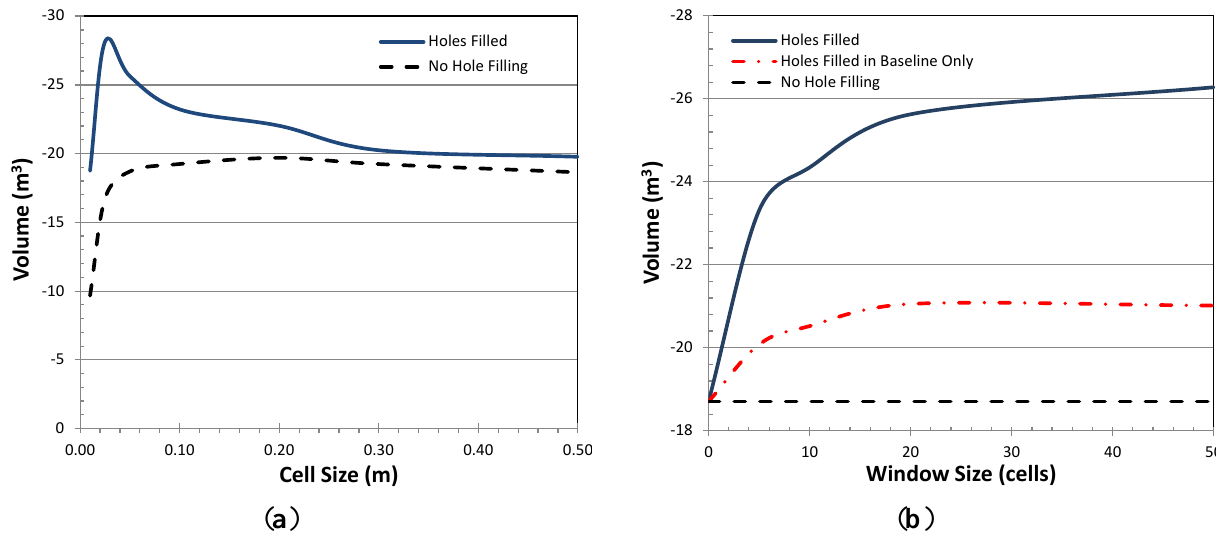
Figure 11. ( a ) Comparison of calculated erosion volumes for various resolutions and with (HF) and without (NHF) hole filling for Site A between 2013 and 2014; ( b ) Comparison of rockfall volumes for Site A with varying hole filling search window size. Computations are based on a cell size of 0.05 m. The plateau indicates that the majority of the holes for Site A were small and filled with a window size of 15 cells (0.775